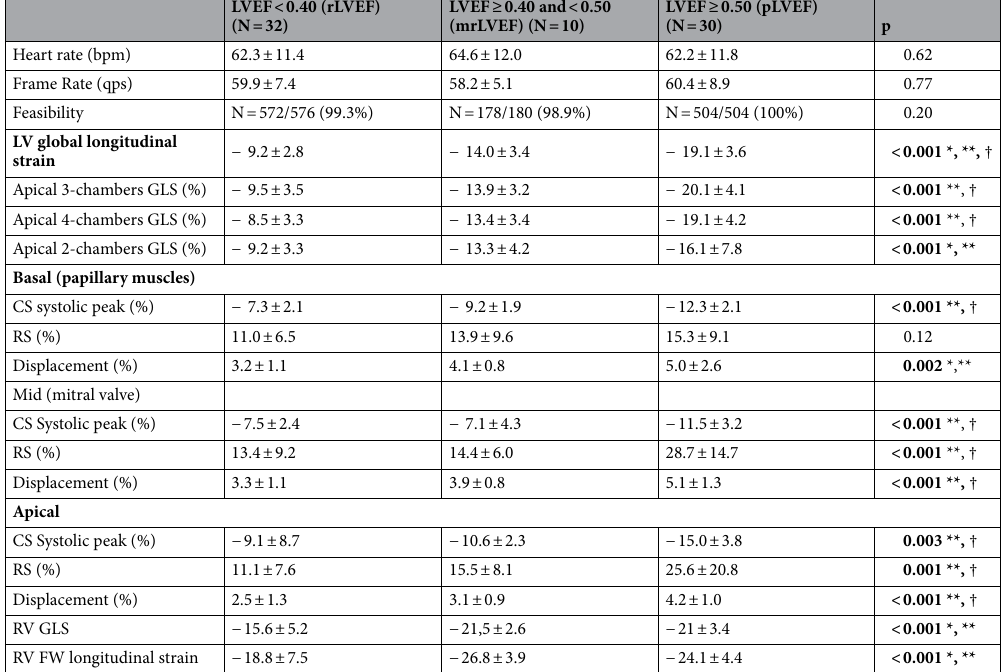
Table 3. Echocardiographic parameters of myocardial longitudinal, radial, circumferential strain and displacement evaluated by 2D STE. Significant values are in bold. * LV Left ventricle, RV right ventricle,